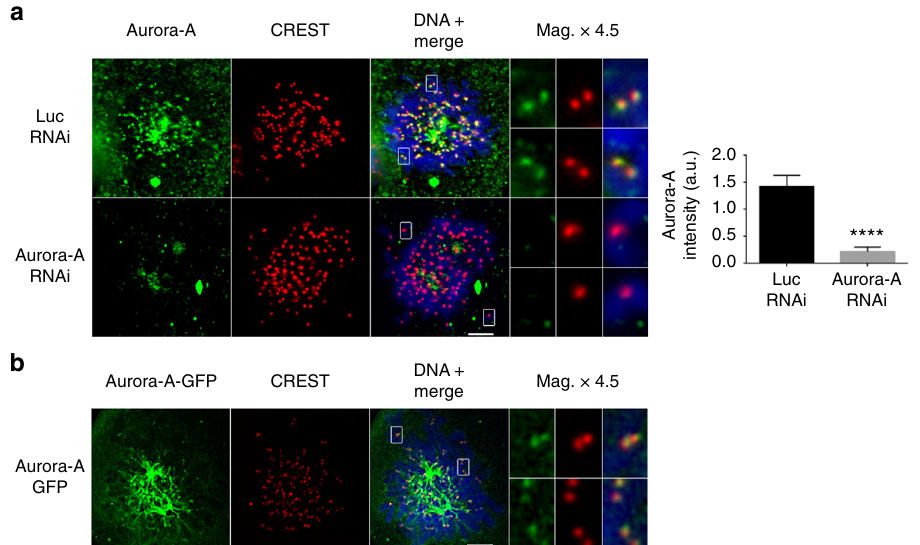
Fig. 4 Aurora A localizes to the centromeres during mitosis. a Immuno fl uorescence microscopy on chromosome spreads, showing staining for Aurora A (green) and CREST (red) in HeLa cells transfected with control or Aurora-A siRNA. Images were overexposed to reveal weak signals. Magni fi cations (× 4.5) of chromosomes, and mean ± SEM quanti fi cations of centromeric fl uorescence signals for Aurora A are shown ( n = 20 cells from a representative experiment; **** P < 0.0001; two-tailed unpaired nonparametric Mann – Whitney U -test). b Immuno fl uorescence microscopy on chromosome spreads, showing staining for Aurora-A-GFP and CREST in U2OS cells stably expressing a GFP-tagged-Aurora-A. Magni fi cations of single chromosomes are shown. Scale bar = 5 µ